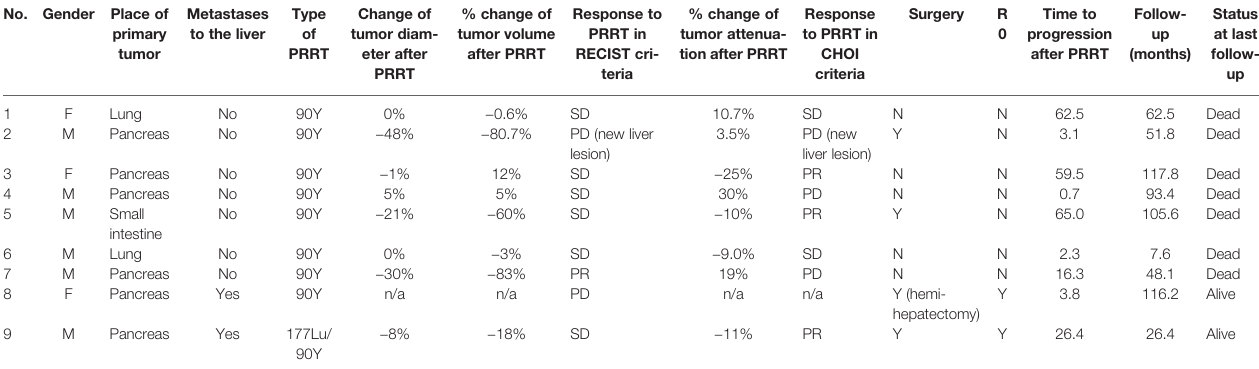
TABLE 3 | Presentation and radiological and clinical outcomes of the patients. No. Gender Place of